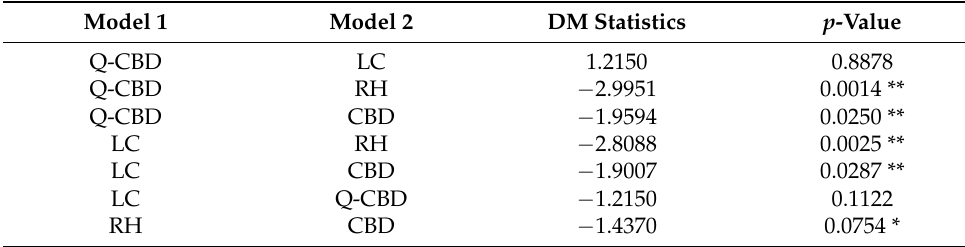
Table 3. Diebold–Mariano (DM) Test for Predictive Accuracy.